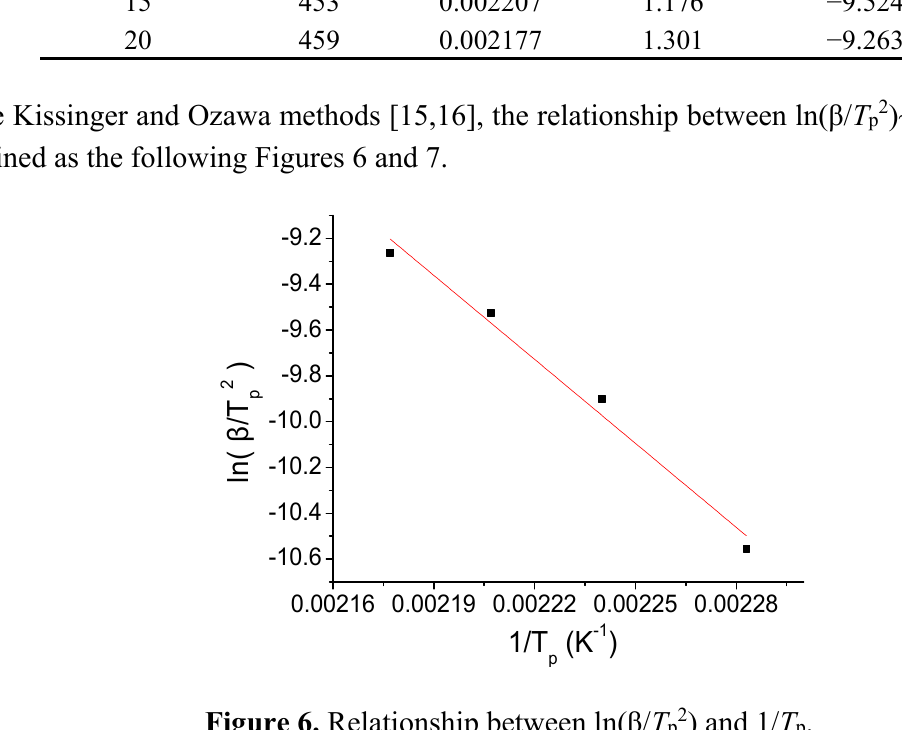
Figure 6. Relationship between ln( β / T p2 ) and 1/ T p